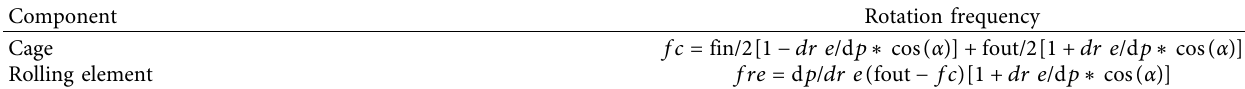
Table 5: Rotation frequencies’ equations of the cage and rolling element.